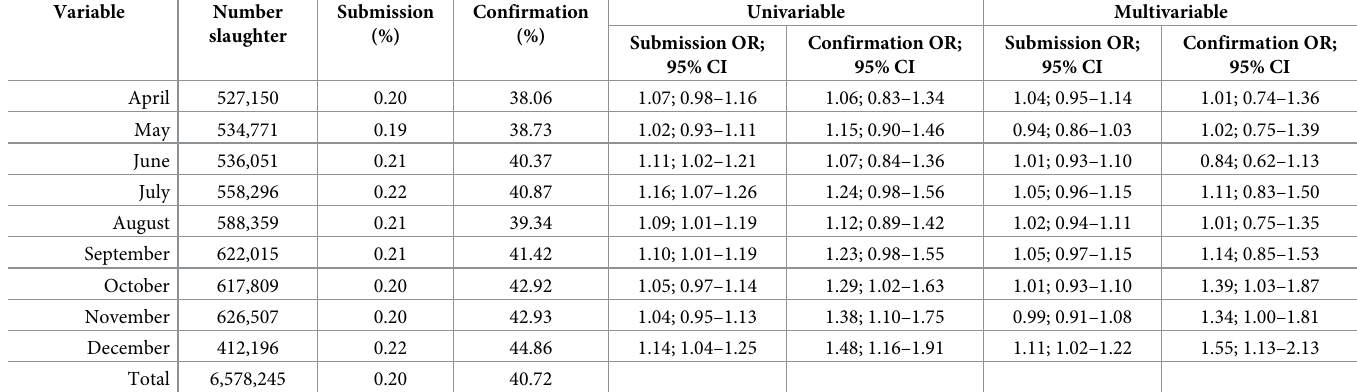
maximum change in factory ranking was 6 positions and the average being 2 positions (S2 Table). Herd as random effect explained 15% of the residual variance (Intraclass correlation (ICC) = 0.15; 95% CI 0.14–0.16) in the multivariable model. The odds of FL submission increased with the increase of animal’s age at slaughter, and the OR of animals over eight years old was 1.91 compared to animals of 1–2 years old. Males had lower odds of having FL submit- ted than females (OR 0.67, 95% CI 0.64–0.70) in the univariable analysis, but the odds increased to 1.05 in the multivariable analysis. Ever inconclusive tested animals under stan- dard interpretation had 74.24 (95% CI 69.39–79.43) times higher odds of FL submission com- pared to never inconclusive animals in the multivariable analysis. The odds were much lower for animals that were defined as inconclusive based on the severe interpretation of the tubercu- lin skin test (OR: 2.83; 95% CI 2.44–3.27). Pure breed animals had lower odds of FL submis- sion (OR 0.80; 95% CI 0.76–0.83) than cross breed animals. Animals originating from suckler herds had slightly higher odds of having submitted FL than animals from beef herds (OR 1.08, 95% CI 1.02–1.14), while dairy herds had lower odds of having FL (OR: 0.83; 95% CI 0.77– 0.90). Herd size was negatively associated with FL submission; an increase in log herd size by one unit (mean 4.3, median 4.6, maximum 7.6) reduced the odds with a factor 0.95 (95% CI 0.93–0.96). A history of bTB breakdown in the past three years increased the odds of having a